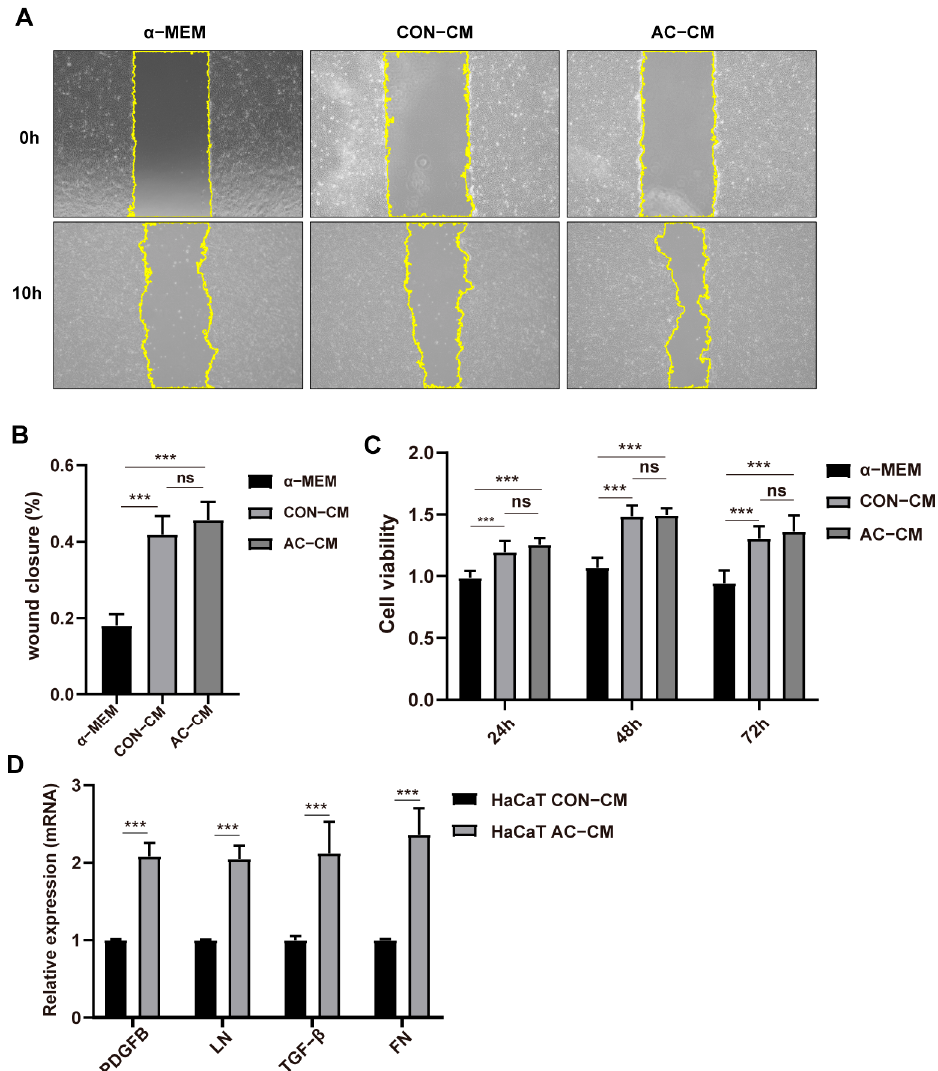
Figure 5. Conditioned medium from AC–ADSCs promotes ECM genes transcription in HaCaT cells. ( A ) Representative scratch test image of HaCaT cells incubated with conditioned medium of CON–ADSCs and AC–ADSCs at 0 and 10 h, and ( B ) Rate of wound area closure after 10 h (%) ( n = 6, scale bar = 100 µ m). ( C ) CCK8 assay was used to evaluate the viability of HaCaT cells incubated with basal medium and conditioned medium of CON–ADSCs and AC–ADSCs ( n = 6), and the statistical analysis of HaCaT cells viability within 72 h (%). ( D ) RT–qPCR analysis in HaCaT cells to detect ECM genes transcription after incubated with basal medium conditioned medium of CON–ADSCs and AC–ADSCs for 48 h ( n = 3). Data are shown as mean ± SD. Independent-sample t test (two–tailed) was used for statistical comparisons between 2 groups; One–way ANOVA followed by Tukey post hoc test was used for statistical comparisons between multiple groups. ** * p <